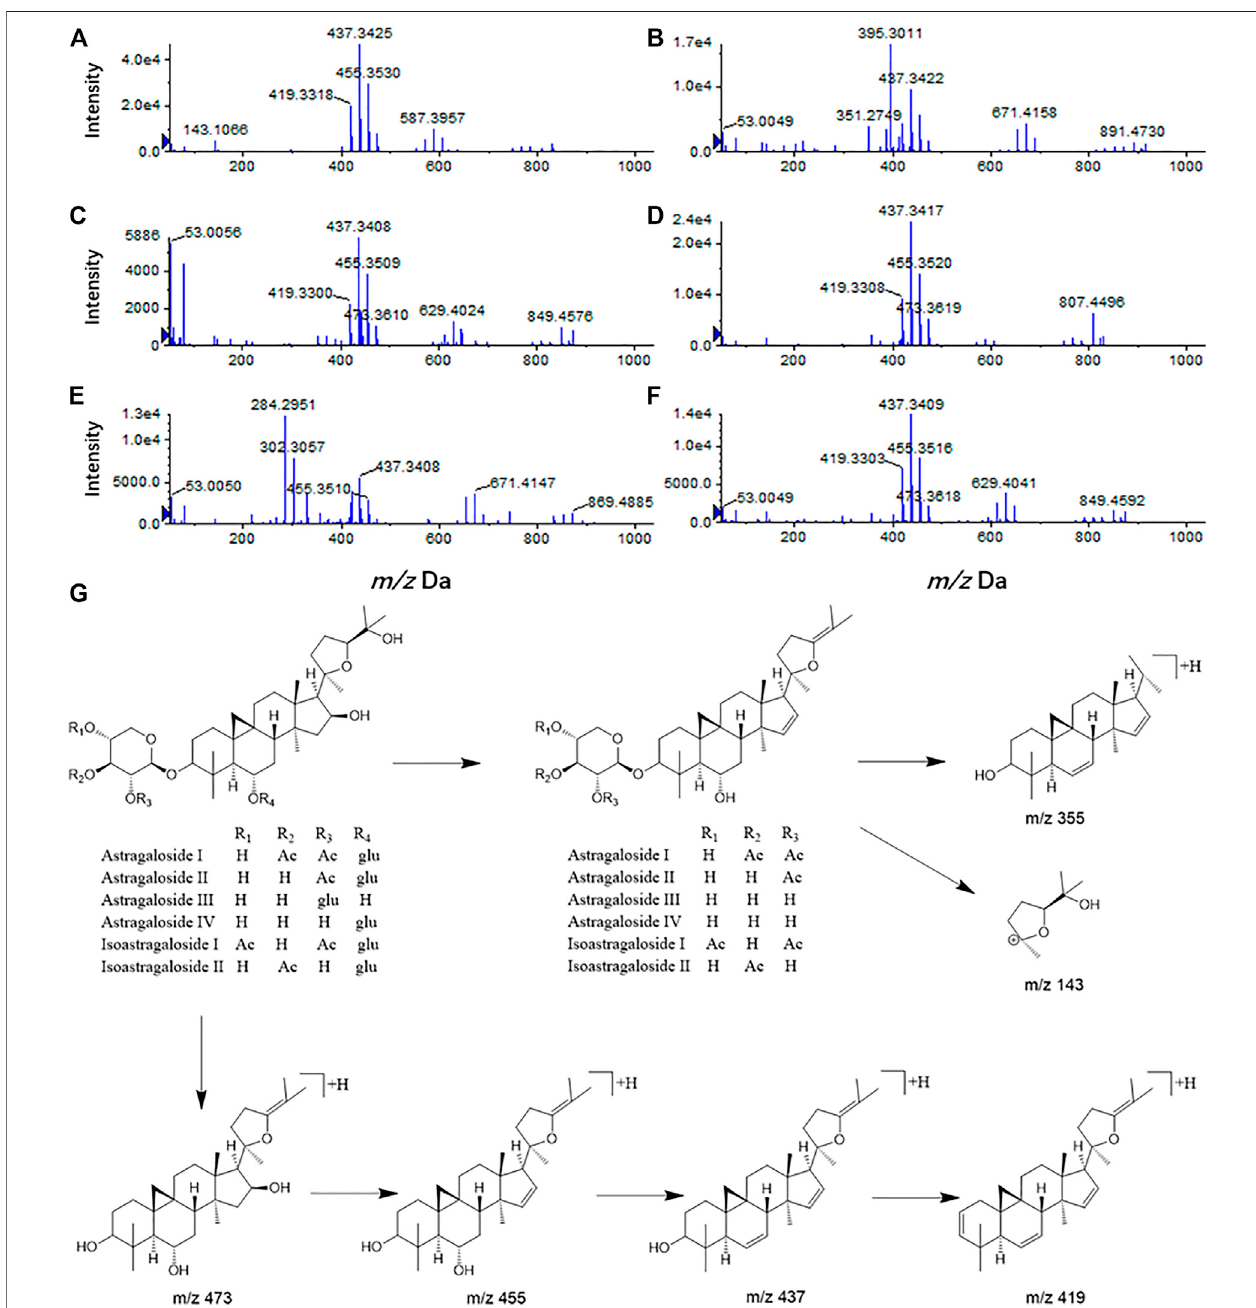
FIGURE4| Massspectrogramofsix Astragalus saponinsandtheproposedfragmentationpathwaysunderapositiveionmode(astragalosideI (A) ,astragalosideII (B) , astragaloside III (C) , astragaloside IV (D) , isoastragaloside I (E) , and isoastragaloside II (F) , six Astragalus saponins (G) .